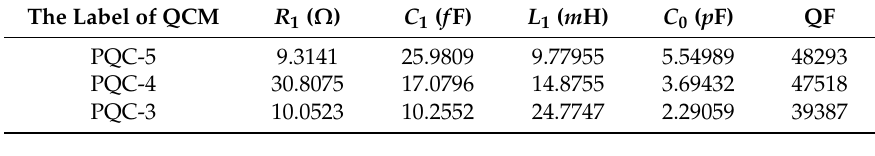
Figure 3. Equivalent circuit model of Interdigital Electrode-Piezoelectric Quartz Crystal (IDE-PQC) sensor. Table 1. The equivalent circuit parameters of 10 MHz PQCs with different diameters of silver electrode.